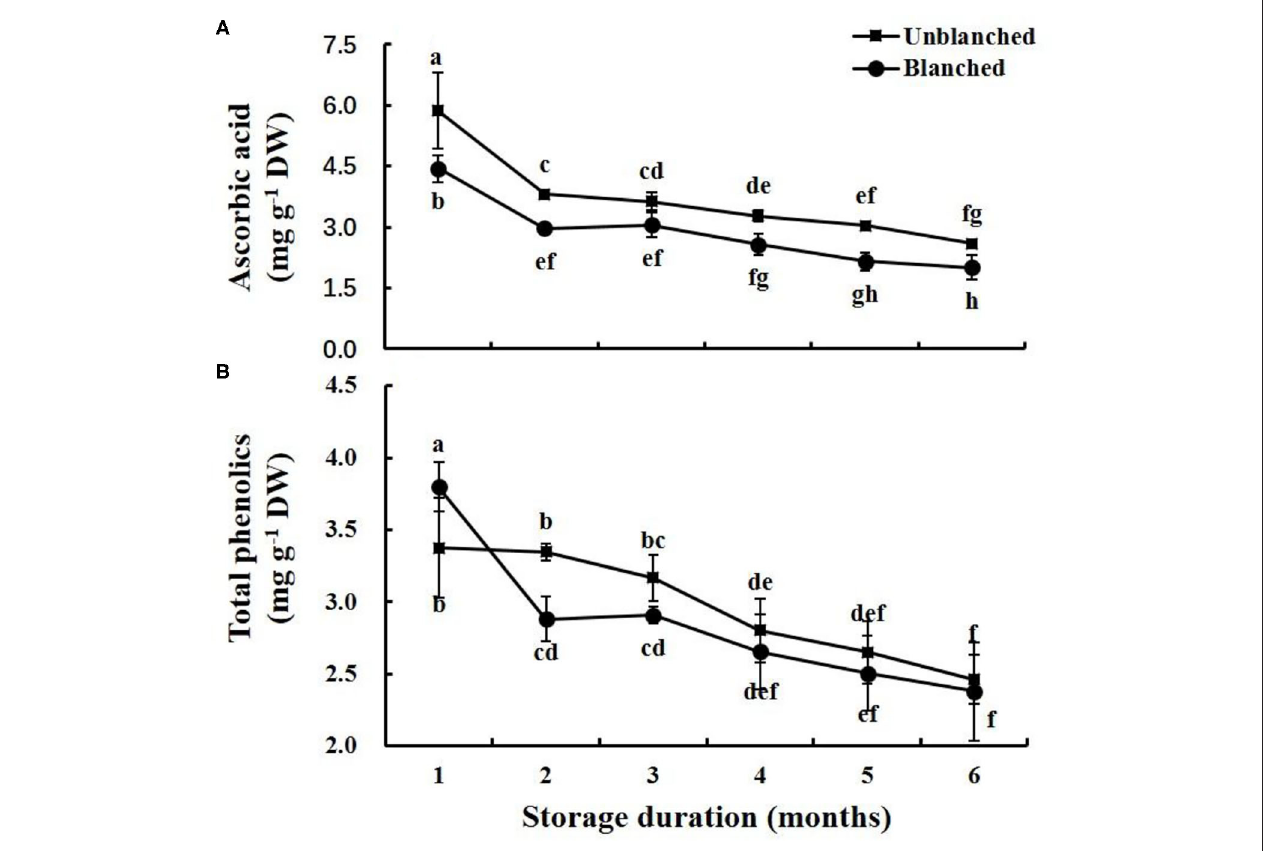
FIGURE 3 | Evolution trend of ascorbic acid and total phenolics contents in baby mustard lateral buds during frozen storage at − 20 ◦ C. (A) ascorbic acid; (B) total phenolics. Unblanched represents no blanching before freezing; Blanched represents blanching before freezing. Values not sharing the same letter are significantly different at p <